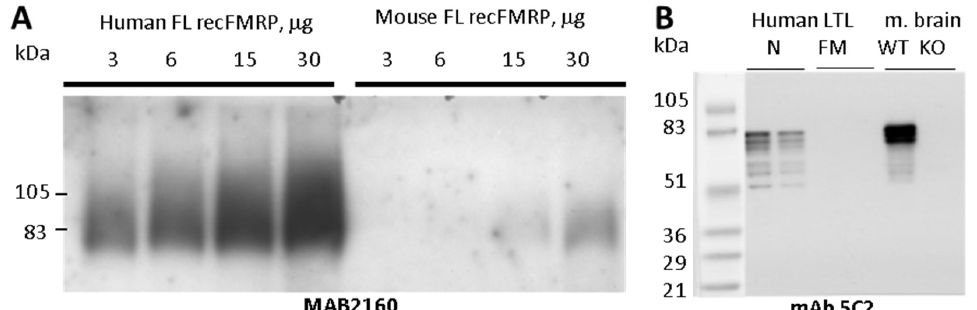
Figure 1. FMRP immunogen characterization and anti-FMRP mAb5C2 immuno-reactivity. ( A ) Purified recombinant full length (FL) human and mouse FMRP loaded at 3, 6, 15, or 30 µg per lane and resolved on 4–15% Criterion Tris-HCl gel and blotted with MAB2160 (clone 1C3). ( B ) mAb5C2 WB analysis of human LTL lysates from normal (N) and full mutation (FM) FMR1 genotype males (30 and 15 µg per lane per genotype) and mouse brain lysates from a wild type (WT) and Fmr1 KO mouse (KO) 15 µg each. Mice were immunized with the recombinant human or mouse FMRP. Hybridoma were produced and screened for reactivity against recombinant immunogen, fragile x re- lated protein 1 (FXR1P) and fragile x related protein 2 (FXR2P) by ELISA. Only FMRP- positive clones that lacked immunoreactivity to FXR1P and FXR2P were isolated, purified, and used for ascites production. The antibodies (all isotyped as IgG1K) were analyzed by WB for reactivity to the recombinant FMRP fragment library, human lymphoblastoid cells, and mouse brain homogenates. The 19 clones with positive FMRP recognition are listed in Table 2. Table 2. Anti- FMRP mAb clones and corresponding epitopes. 347–353, 347 PNAPEEK